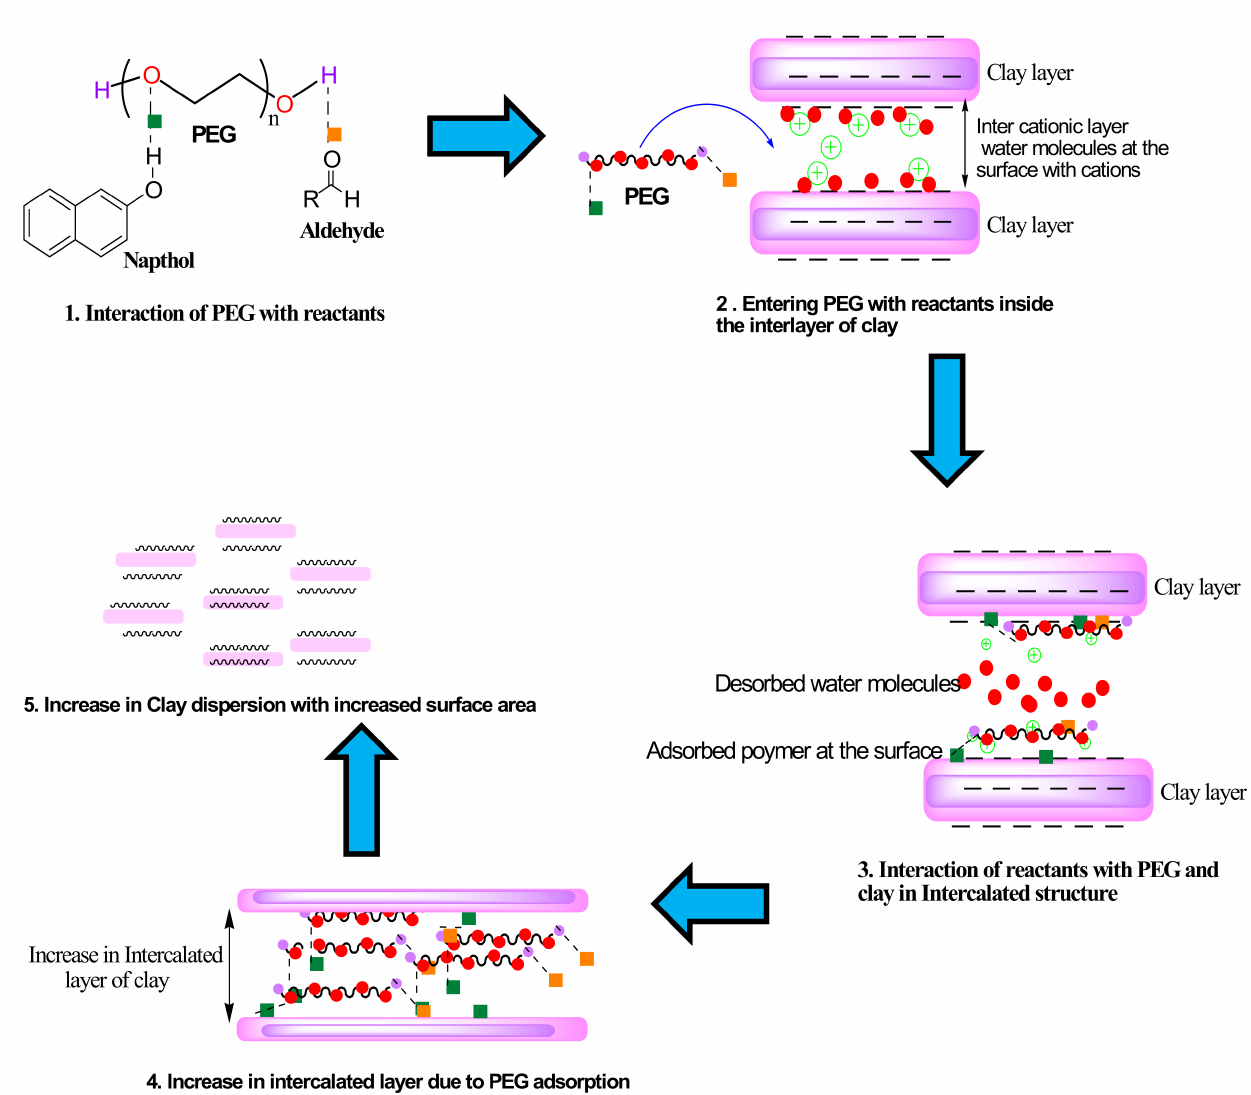
Figure 4. Graphical illustration of probable adsorption of PEG along with reactants on clay